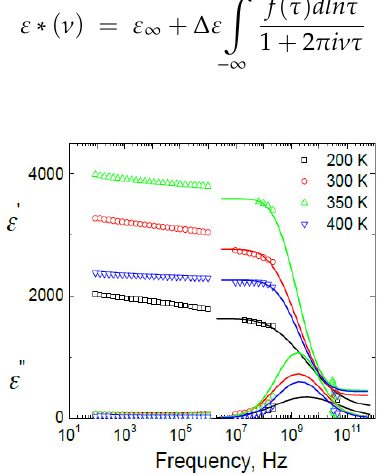
Figure 4. Frequency dependence of the real and the imaginary part of complex dielectric permittivity ε * = ε ’ − i ε ” for Ba 0.83 Ca 0.17 TiO 3 ceramics measured at several temperatures. The lines denote the best fit according to Equation (1).